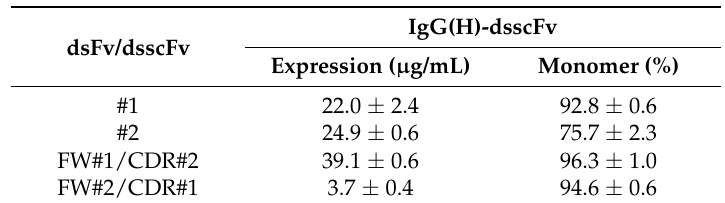
Table 4. Comparison of IgG(H)-dsscFv with wild type and FW/CDR-‘swapped’ Fv. Following the 10-day transient expression in 293F cells, the expression level of wild type and framework ‘swapped’ IgG(H)-dsscFv proteins in the culture supernatant was measured by a Protein G HPLC assay. Proteins were purified from the supernatant using Protein A HPLC, and the purified proteins analysed by G3000 SEC.